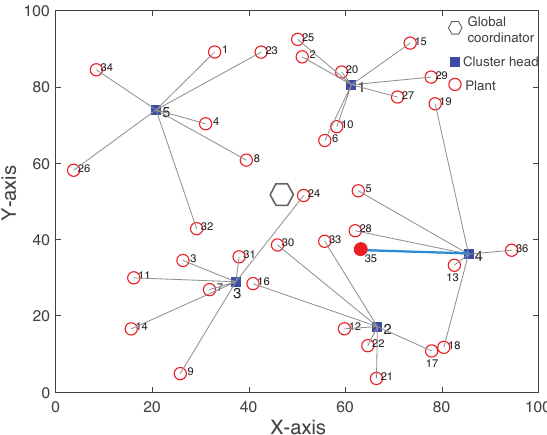
Figure 7. Clustered network topology with N p = 36 and N ch = 5. The hexagon, rectangle, and circle represent global coordinator, cluster head, and plant, respectively. The link between plant and cluster head indicates the associated cluster. The intra-cluster sensing link between plant 35 and cluster head 4 is failed at 110 time slots.